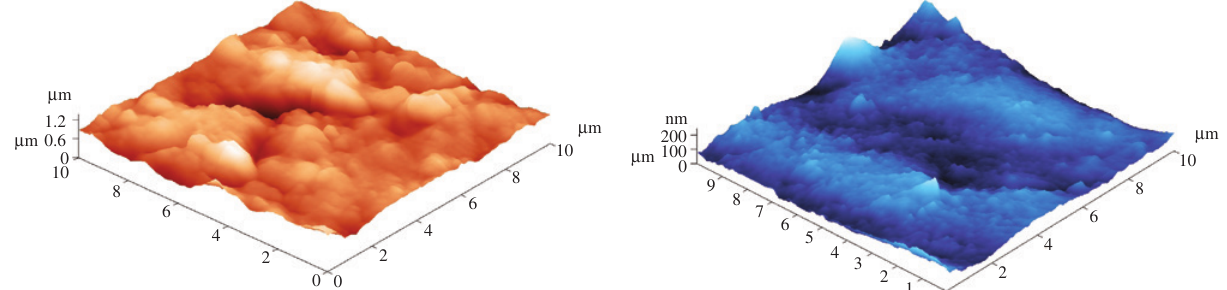
Figure 23: AFM analysis of GFRP with 1% CNTs–3D analysis.